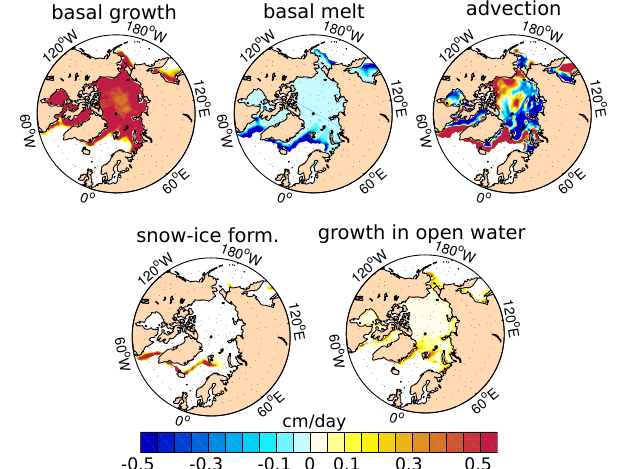
Figure 7. Horizontal distribution of the five relevant processes con- tributing to the sea ice mass balance in March in the Northern Hemi- sphere, from the ORCA2-LIM3 simulation. Units are in cmday − 1 . Positive and negative values represent creation and destruction of sea ice, respectively.